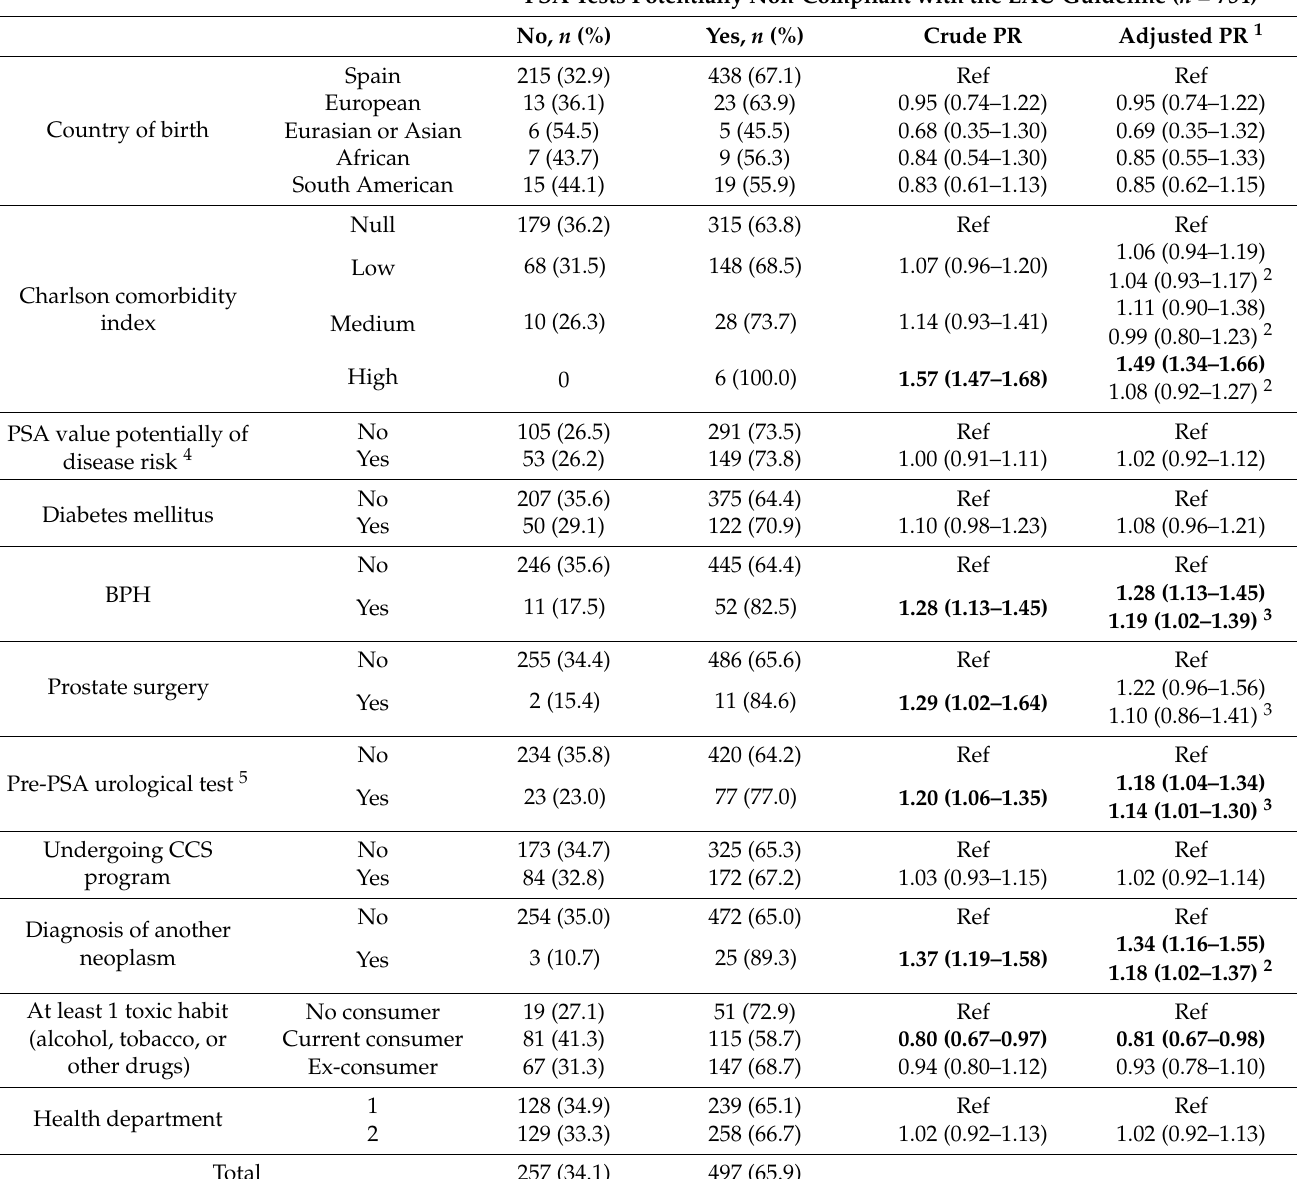
Table 2. Relationship between prostate-specific antigen request potentially compliant with the EAU guideline and potential explanatory variables in asymptomatic